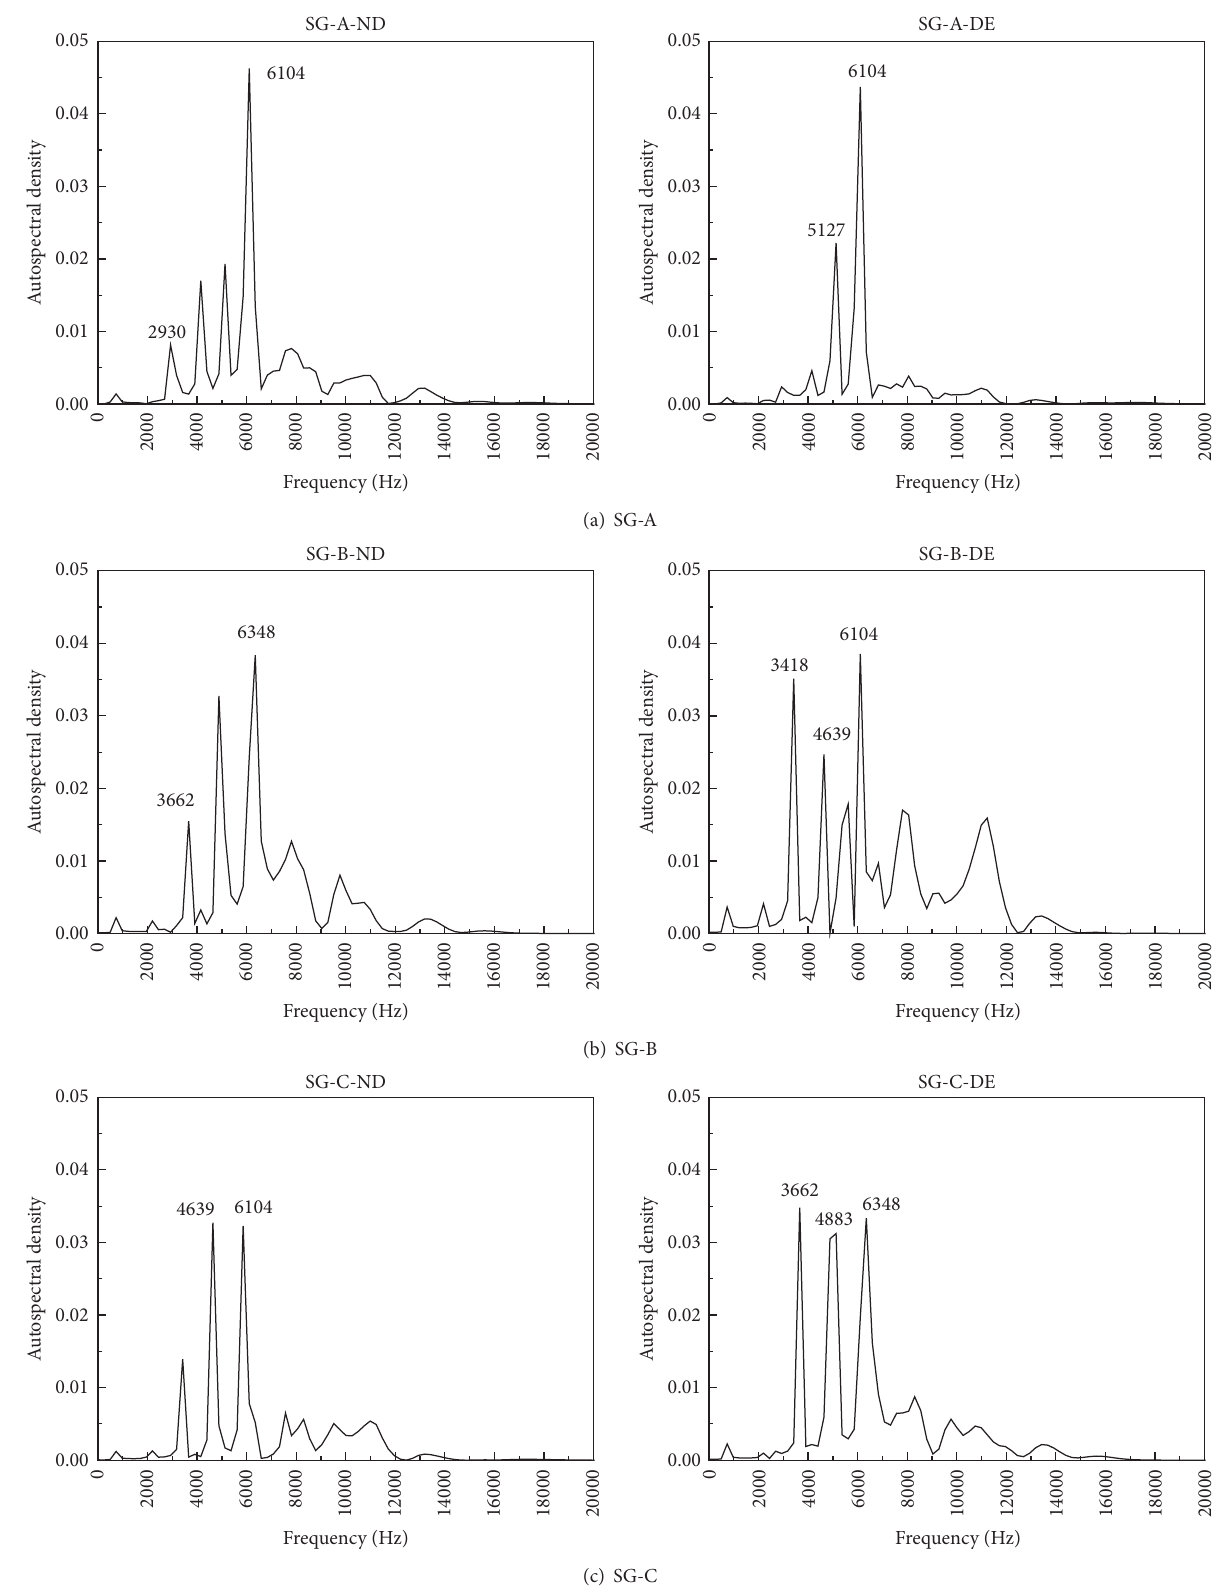
Figure 11: Frequency domain graphs after FFT of accelerated velocity-time